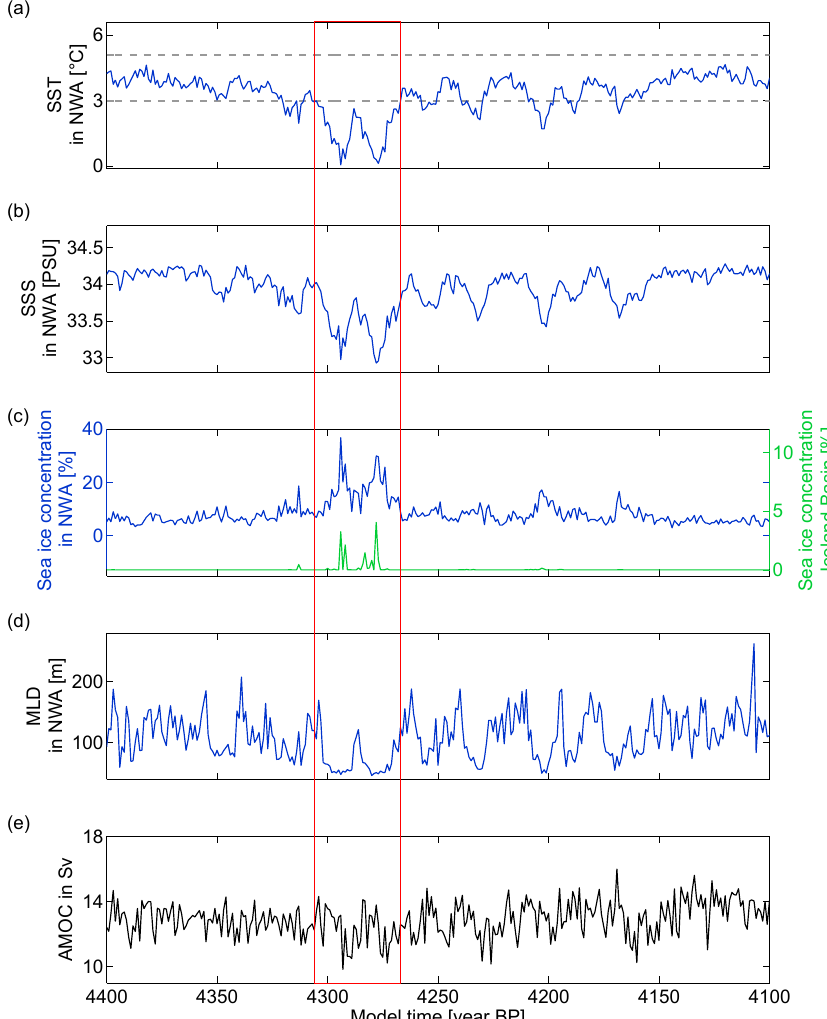
Figure 4. Zoom in on event 1. Same fields as in Fig. 2. The red box indicates the time span of the first